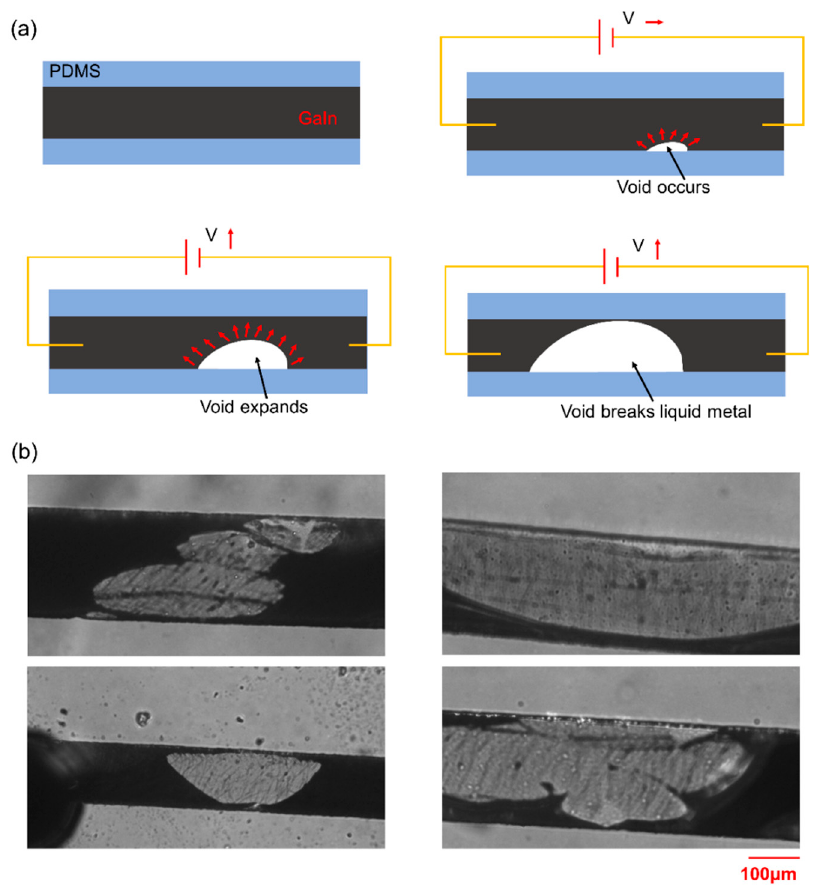
Figure 4. ( a ) Whole process of the liquid-metal break-up within the heating channel induced by voids. ( b ) Microscopic view of the final liquid-metal break-up within the heating channel.